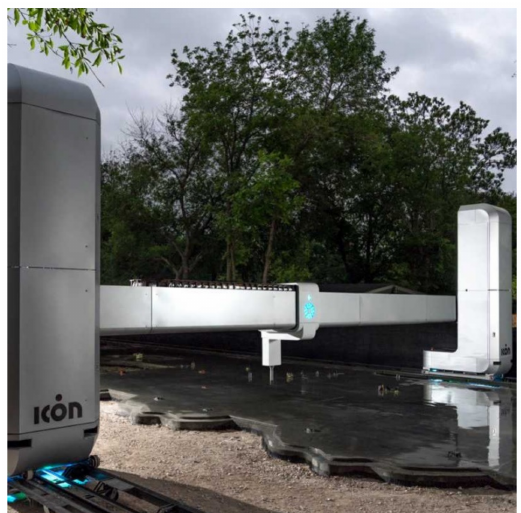
Figure 1. ICON Printer [19]. Reprinted with permission from Ref. [19]. 2022,